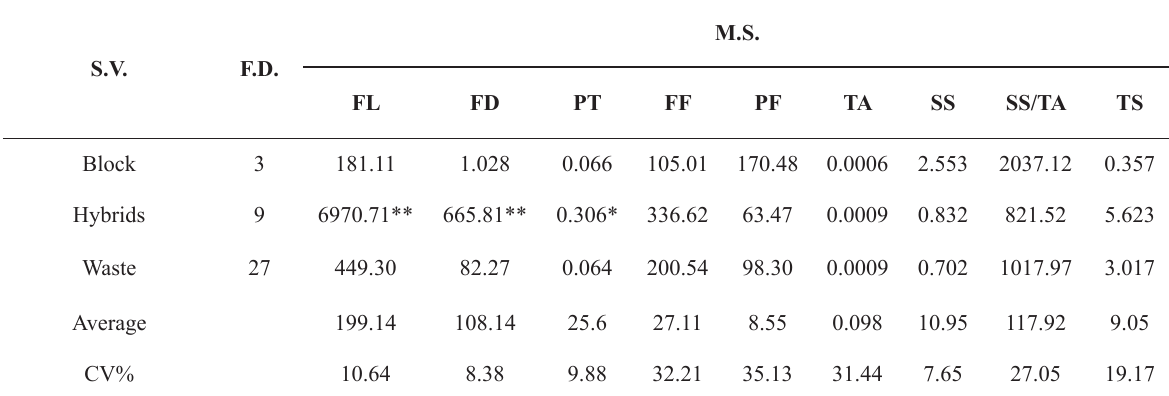
Analysis of variance of the fruit qualitative